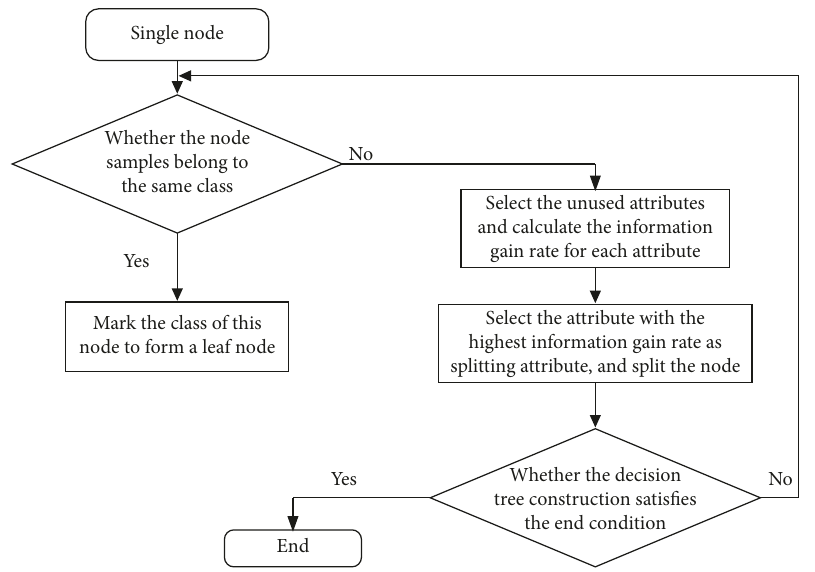
Figure 1: Decision tree construction process.